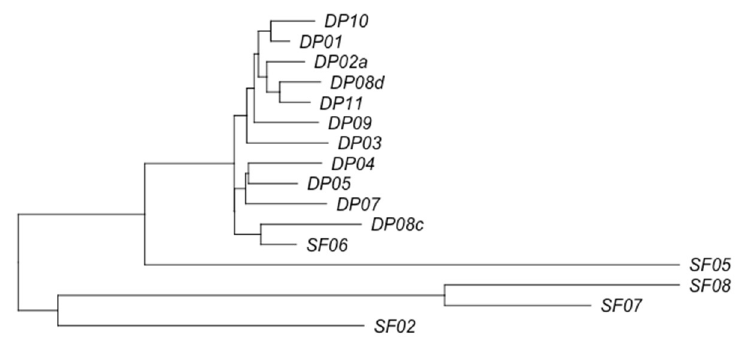
Figure 4. Phylogenetic tree obtained for sequences of amplicons generated with Lactococcus P335 phage-type primers with metagenomic DNA from curd cheeses from dairy plants (DP-) and spontaneous in-house fermentations (SF-).